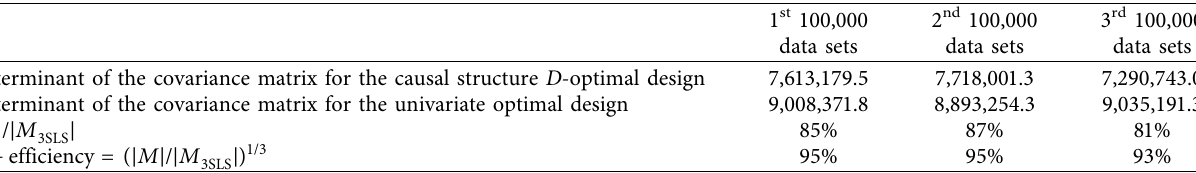
‡ See [10]. Table 4: Determinants of the covariance matrices for the 3SLS causal structure D -optimal design and the 3SLS univariate optimal design based on three simulations each with 100,000 data